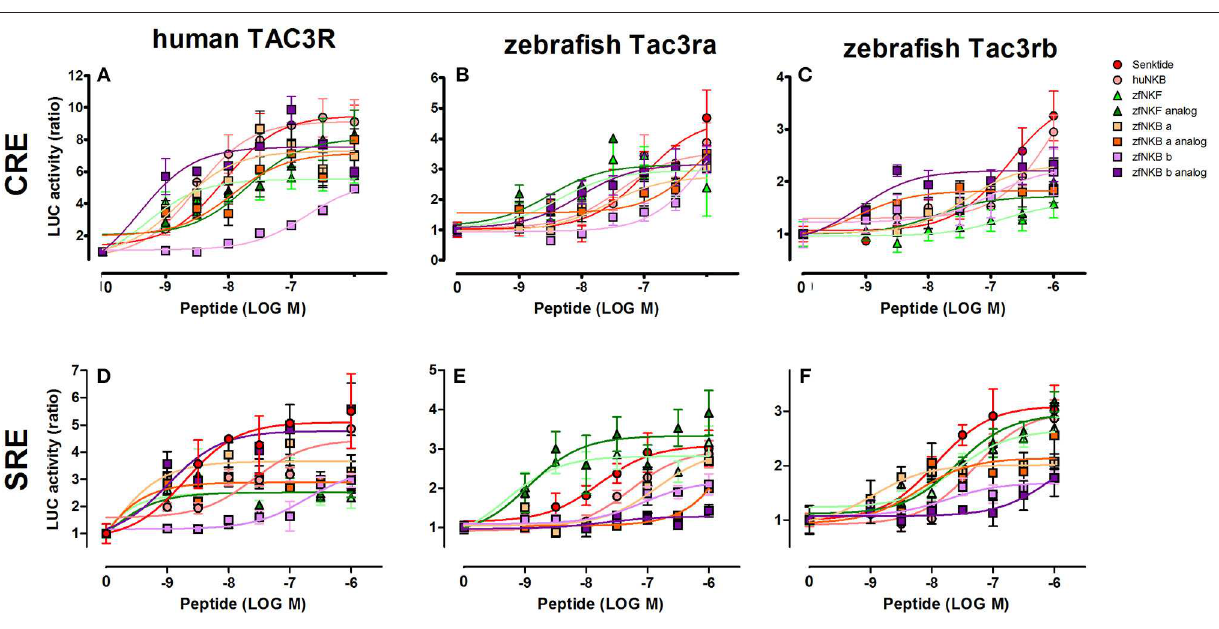
current investigation, the cAMP/PKA pathway showed increased activation by the NKB and NKF agonists. Upon binding to the Tac3 receptors, the tilapia and the zebrafish NKB/NKF analogs